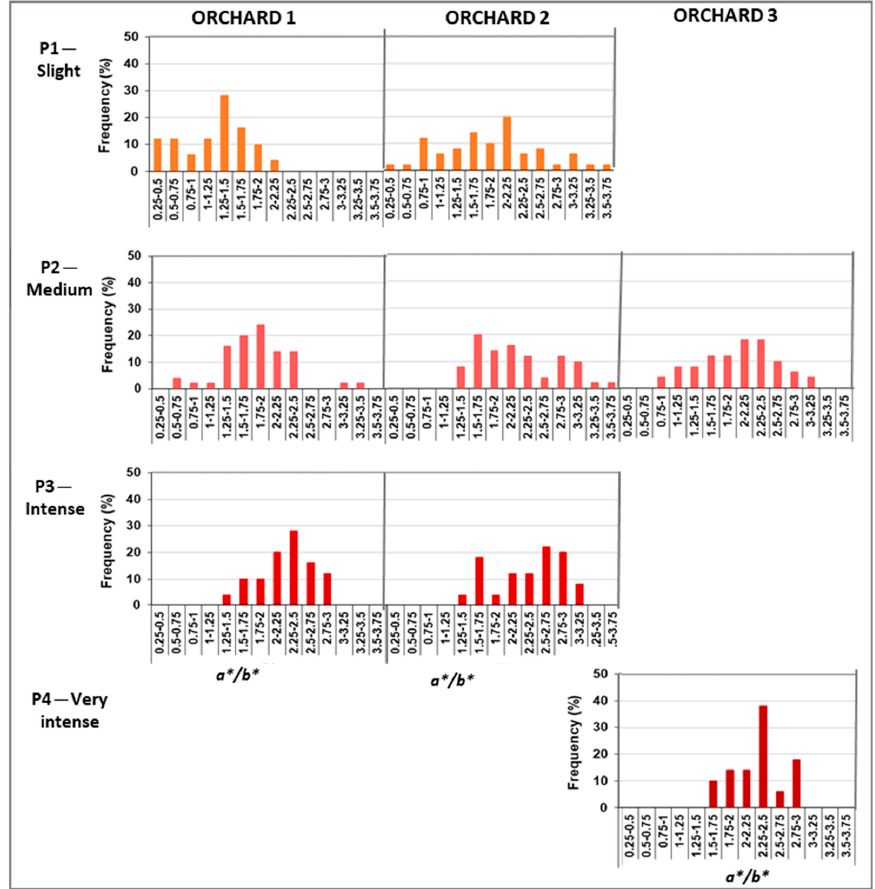
Figure 3. Frequency distribution of the pulp colour (a*/b* values of juice) of ‘Sanguinelli’ blood oranges grouped according to rind pigmentation (P1—slight, P2—medium, P3—intense, P4—very intense). Each group of intensity per orchard consisted of 50 individually analysed